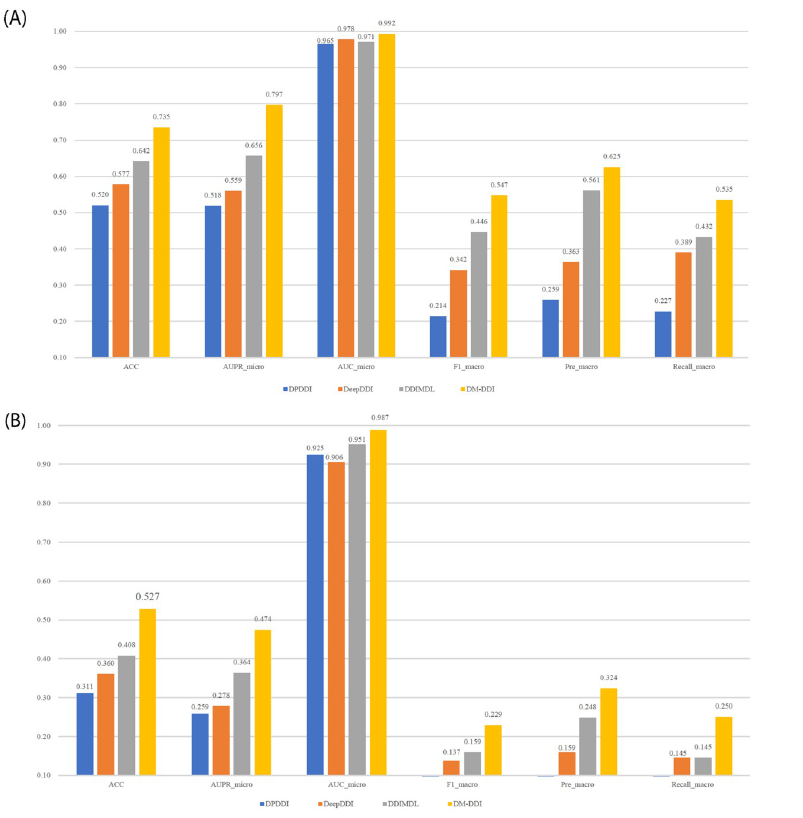
Fig 5. Experimental results in different tasks. (A) Task A. (B) Task